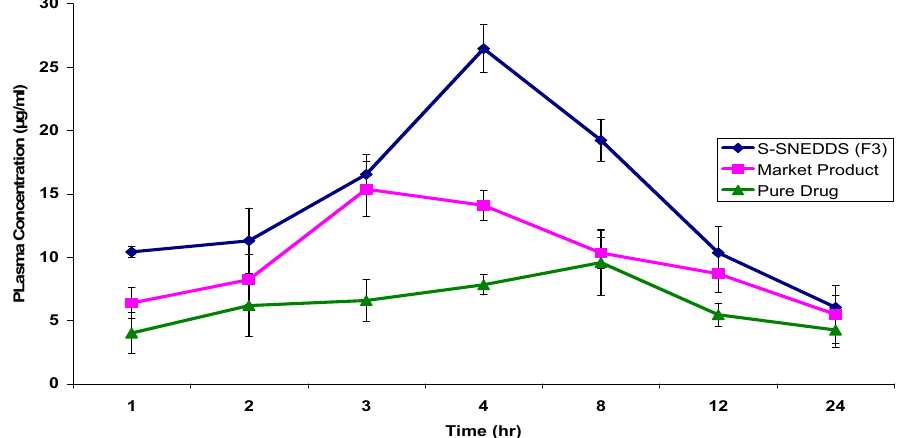
Figure 12. Plasma concentration-time profiles of OLM after oral administration of optimized S-SNEDDS formula (F3), Marketed product and pure drug in rats ( n = 6).